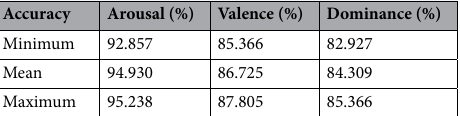
Table 4. Minimum, mean and maximum accuracy of feature fusion-based SVM method.